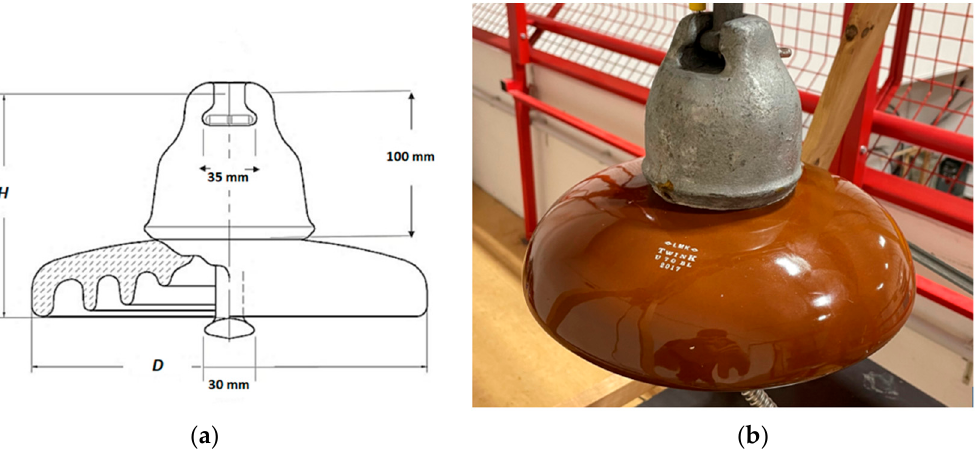
Figure 1. U 70 BL porcelain insulator: ( a ) Parameters; ( b ) Used insulator. The ambient temperature ranged from 22 °C to 25 °C during the measurements.